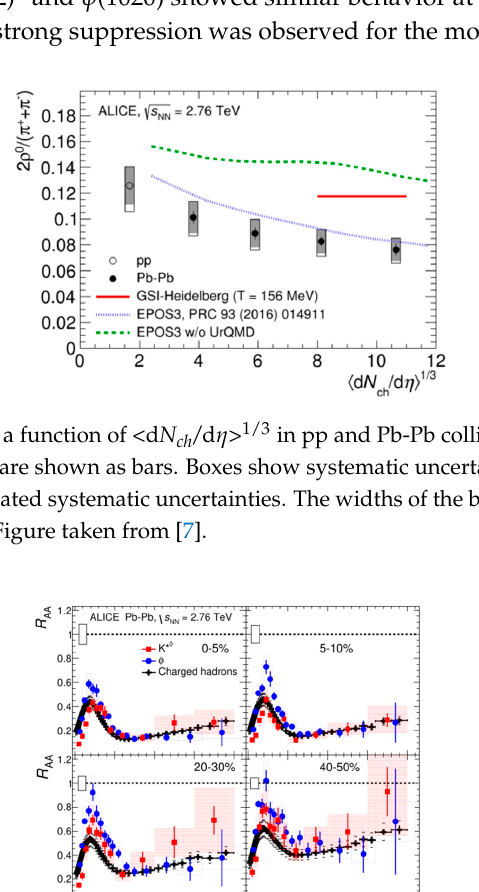
Figure 7. The R AA of K*(892) 0 and φ (1020) as a function of p T in the 0–5%, 5–10%, 20–30% and 40–50% centrality classes for Pb-Pb collisions at √𝒔 𝐍𝐍 = 2.76 TeV. The statistical (systematic) uncertainties are shown as bars (boxes). Figure taken from [10].